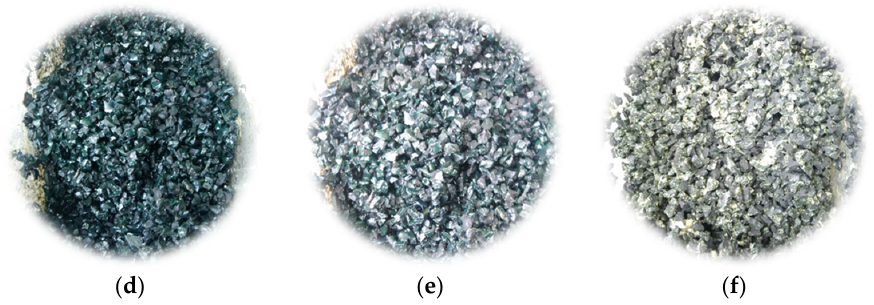
Figure 3. Crumb rubber after pretreatment. ( a ) Emulsion; ( b ) ethoxyline resin; ( c ) synthetic resin; ( d ) amino ‐ acrylate; ( e ) chloroprene adhesive; ( f ) unsaturated resins.